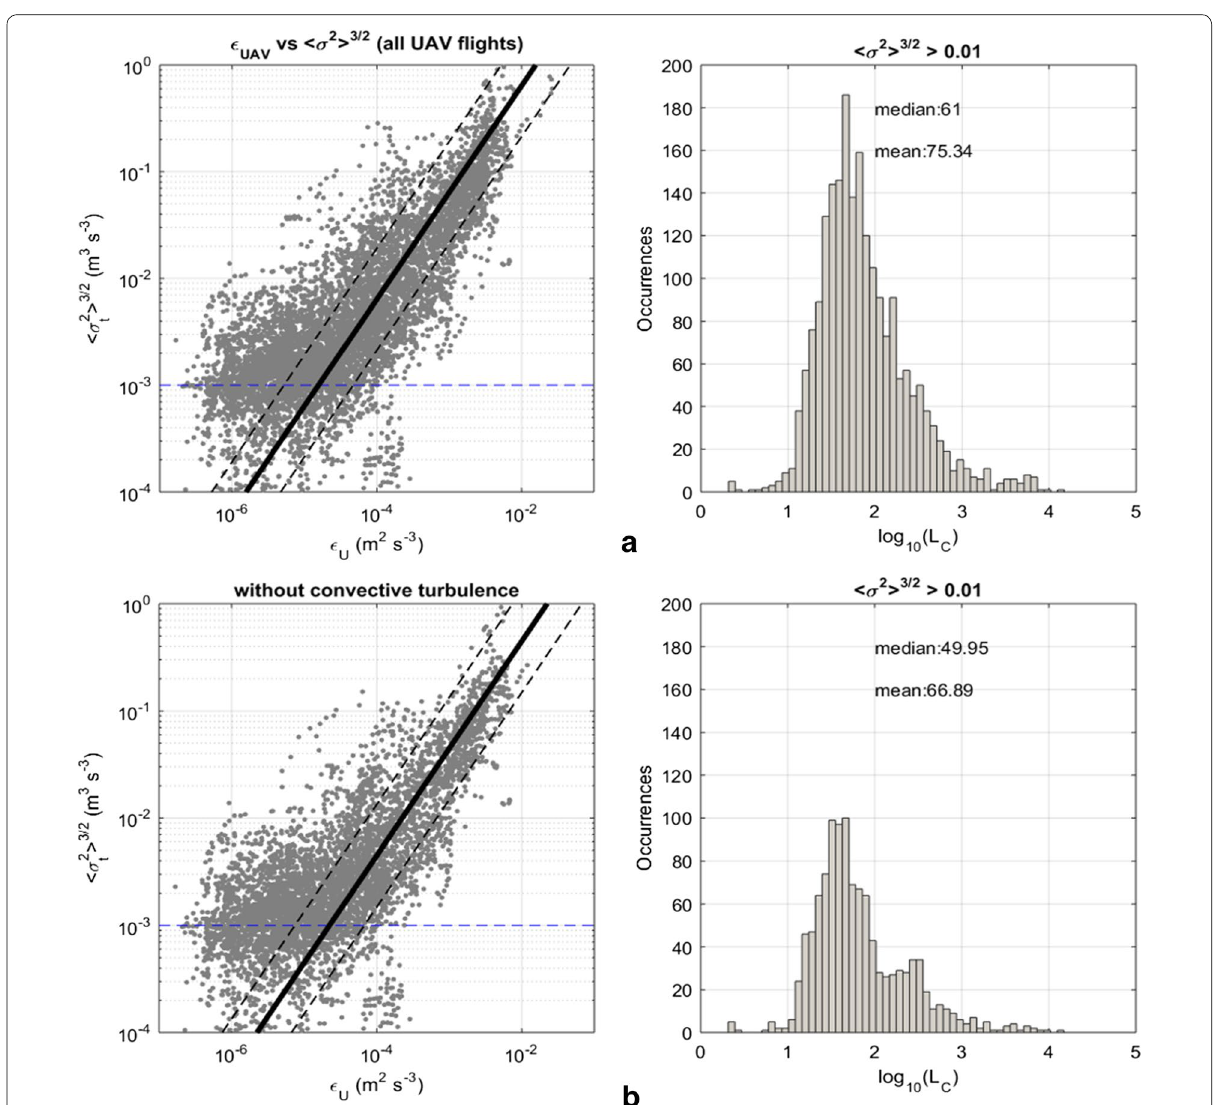
3 / 2 versus ε σ 2 U for all 2016 and 2017 UAV flights except FLT16-21. σ 2 was calculated as shown in (cid:31) (cid:30)